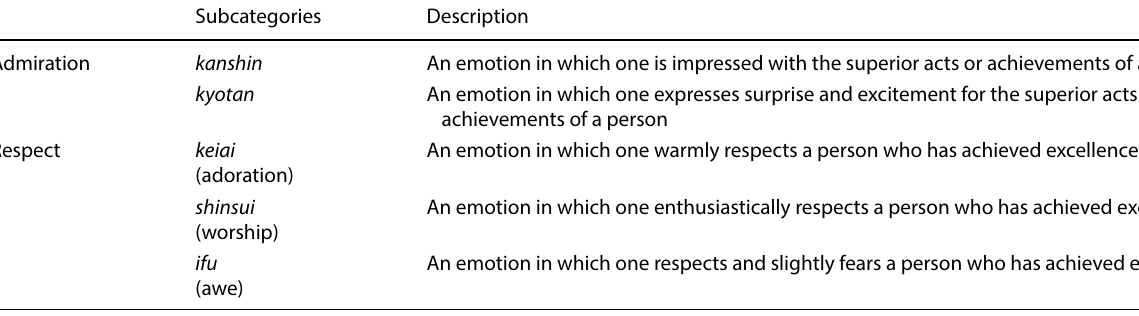
Fig. 2 Scenes captured from the four video clips. The person on the left played the role of the interviewer, and the person on the right played the English lecturer accord- ing to a written script. During the experiment, participants were unaware that they were actors. In the video, the lec- turer provided tips for obtain- ing a high score on TOEIC- style exams in response to the interviewer’s questions. The participants were randomly assigned one of four videos